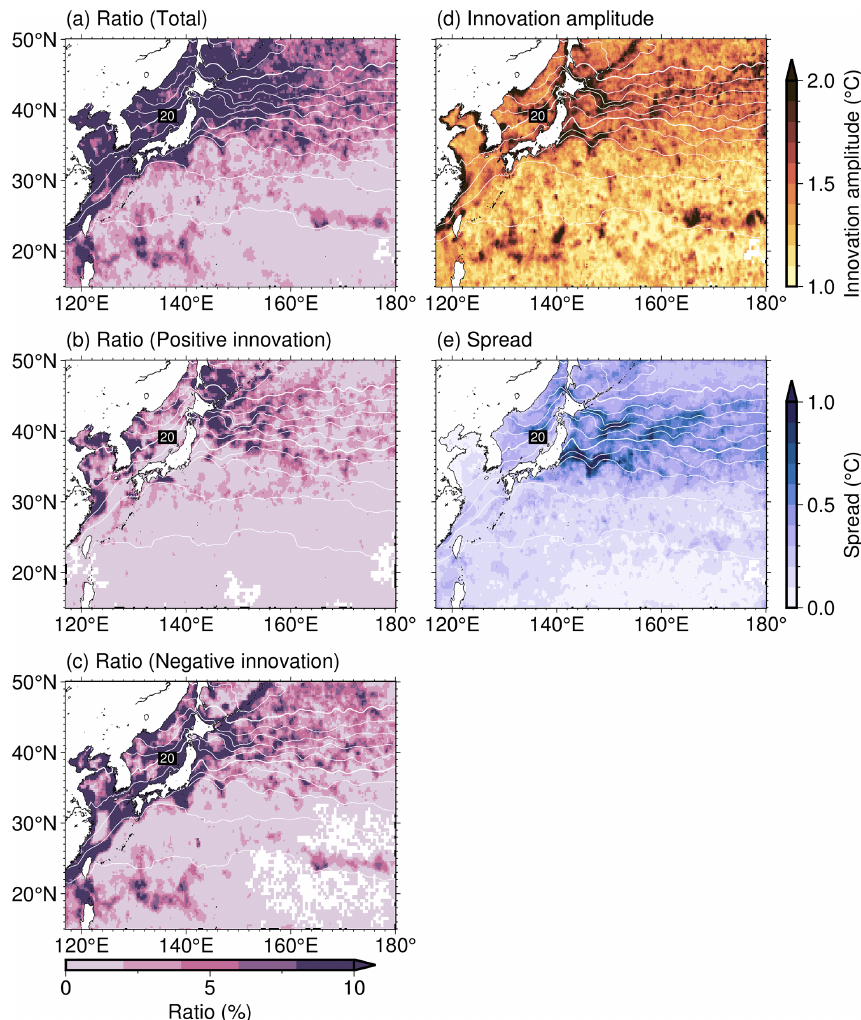
Figure 5. (a) Ratio of the period when the AOEI is applied to the SST compared with the whole experimental period in the AOEI run. Panels (b) and (c) are the same as panel (a) but for when the innovation is positive and negative, respectively. Panels (d) and (e) show the innovation amplitude and ensemble spread averaged during the period when the AOEI is applied, respectively. White contours indicate SST averaged over the whole period. Thin (thick) contour intervals are 2 (10) ◦ C. White areas indicate no AOEI